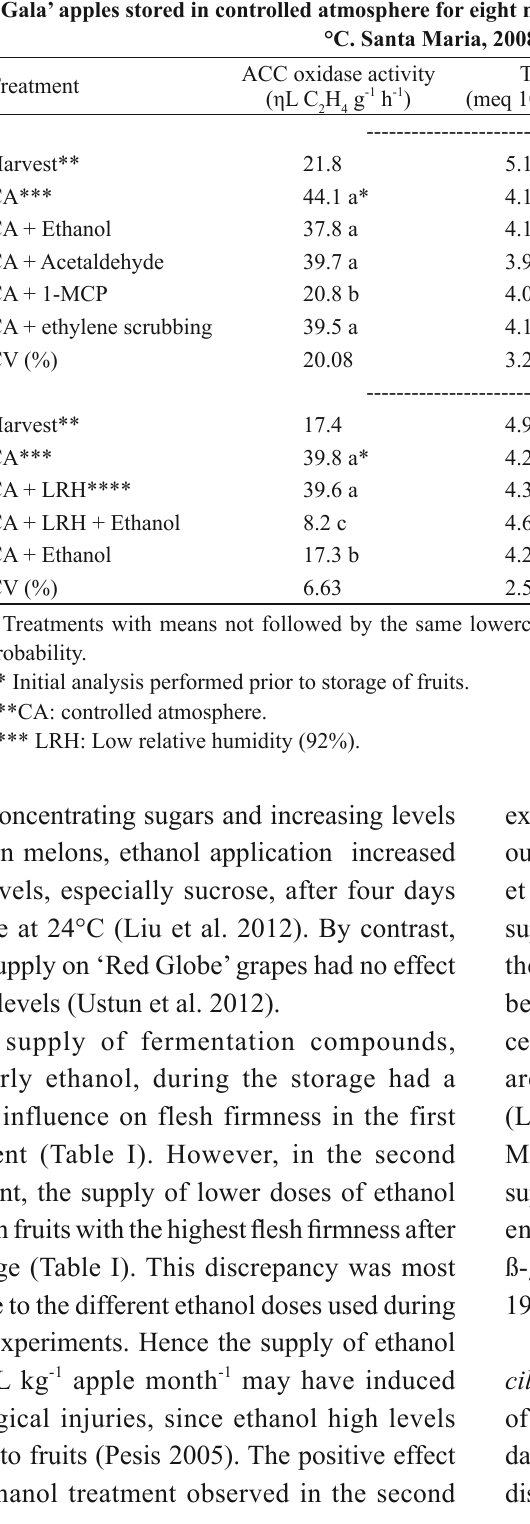
FERMENTATION DURING APPLES STORAGE